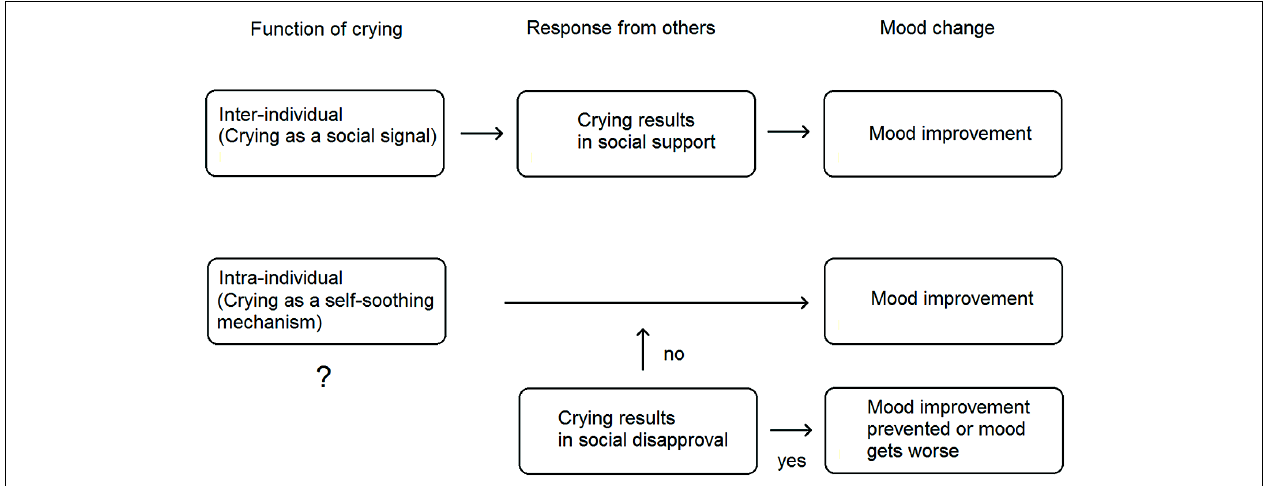
FIGURE 3 |A model of socially mediated and moderated effects of crying on